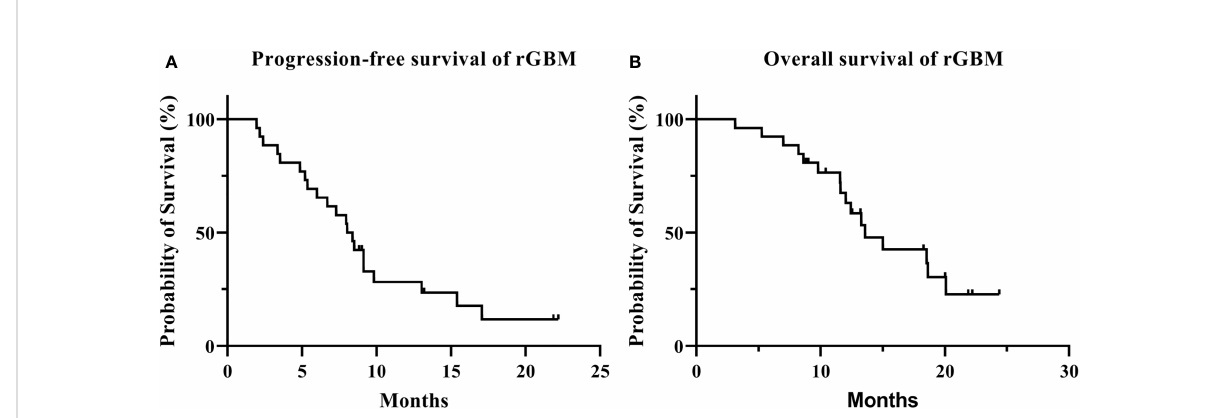
FIGURE 3 Progression-free survival (A) and overall survival (B) of recurrent